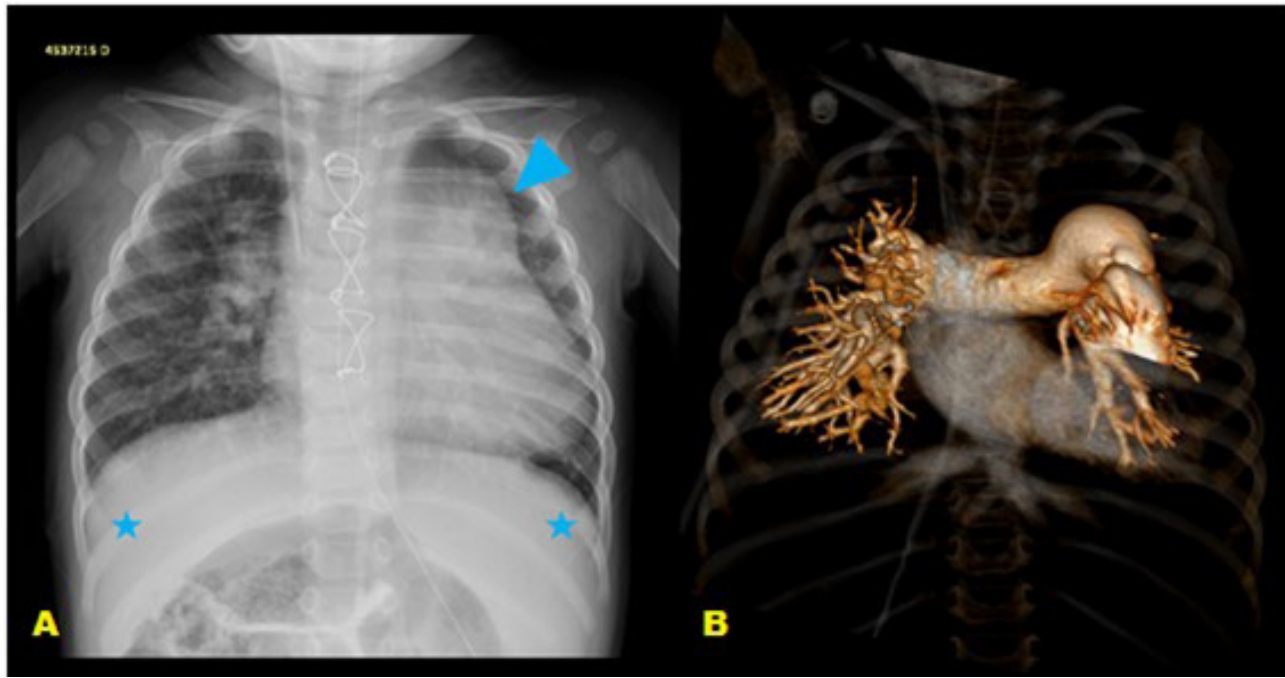
Fig. 1 - (A) Anteroposterior chest radiography showing accentuation and cephalization of the pulmonary vasculature network, and prominence of pulmonary hila with bulging of the middle arch (arrowhead) and increased cardiac area. Medialized hepatic shadow (*) occupying part of the right and left hypochondria. (B) Coronal image of the chest from a three-dimensional reconstruction of computed tomography angiography confirming that the prominence of the pulmonary hila and the bulging of the middle arch described in A correspond to the noticeably dilated pulmonary trunk and